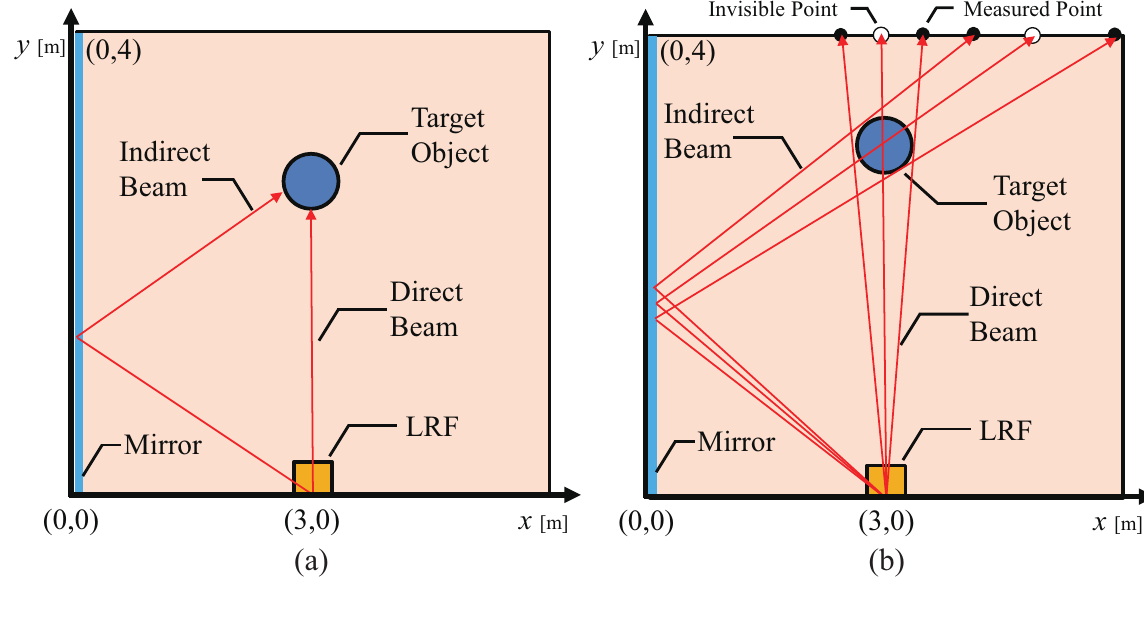
Figure 2. Position measurement using reflected laser beam and diffused laser beam: ( a ) position measurement using reflected laser beam, ( b ) position measurement using diffused laser